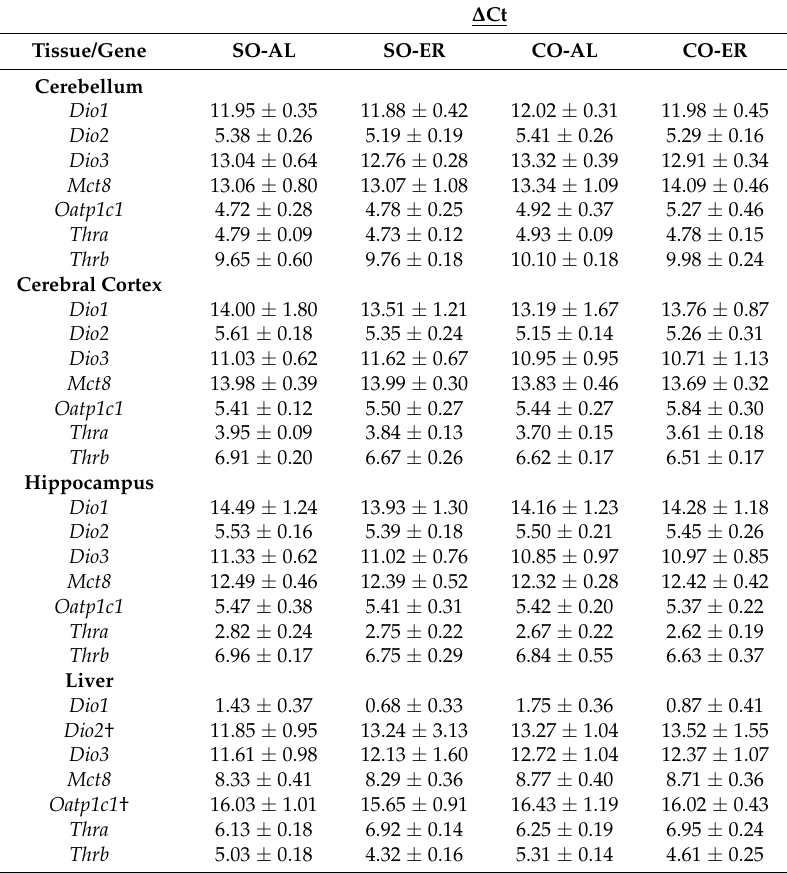
Table A4. ∆ Ct values for TH mediators.